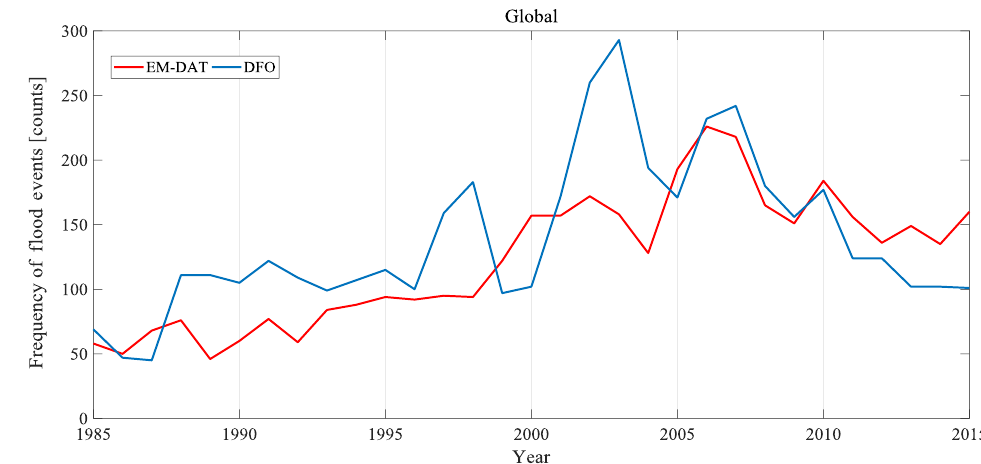
Figure B1. Frequency of flood events from the DFO database and EM-DAT at the global scale (1985–2015).